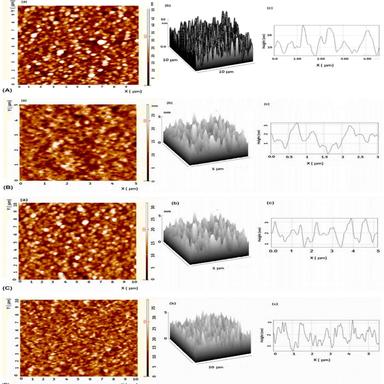
(A–D) 2 D and 3D of AFM images and its roughness tracer analysis of Tb-doped NiO (A) 1%, (B) 2.5%, (C) 5% and (D) 10%.